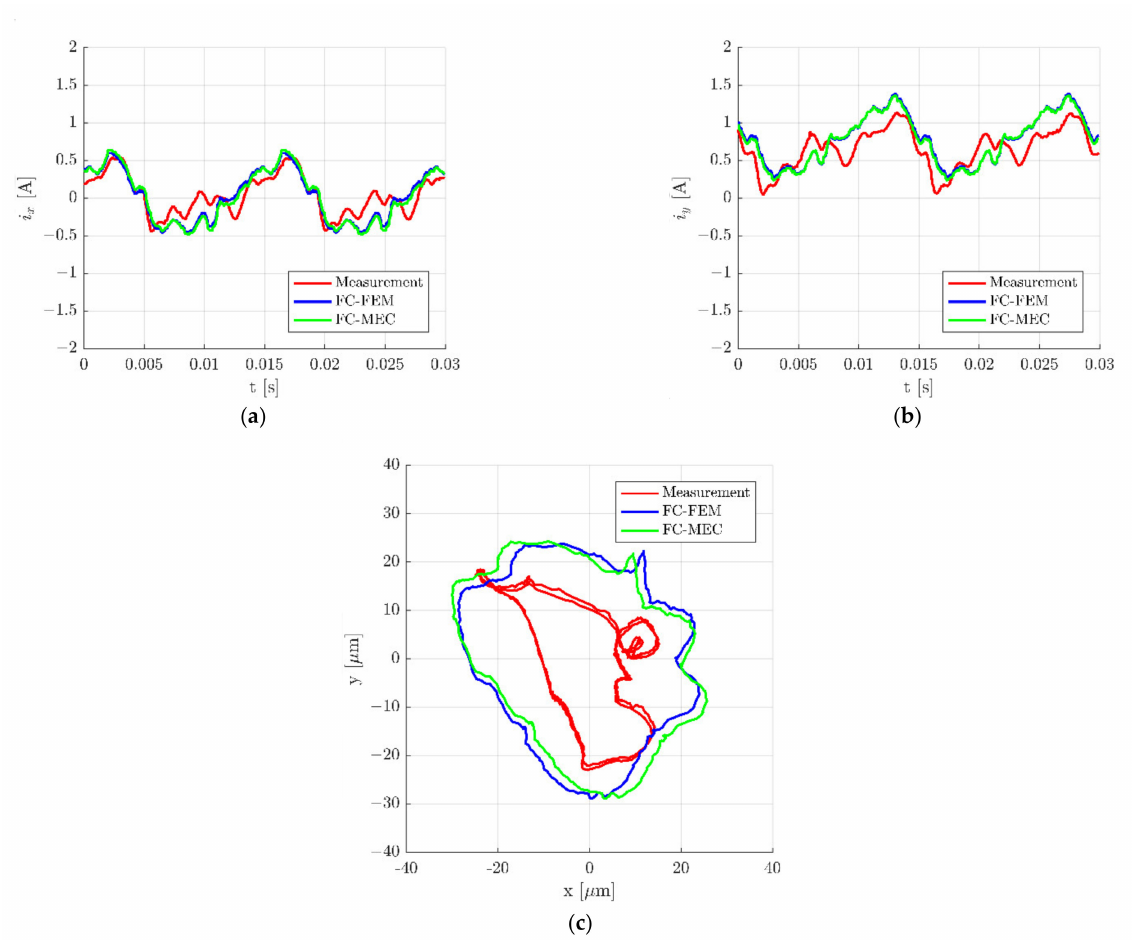
Figure 14. Time responses of the control currents i x ( a ) and i y ( b ) as well as the position of the rotor along the x - and y -axis ( c ) during rotation of the rotor with the speed 4123